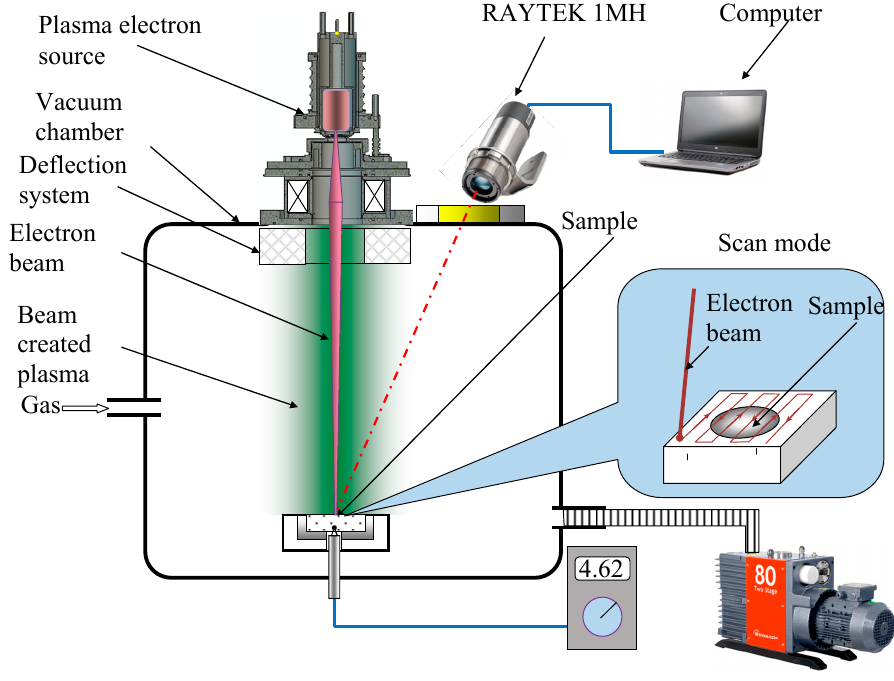
Figure 1. Experimental setup.